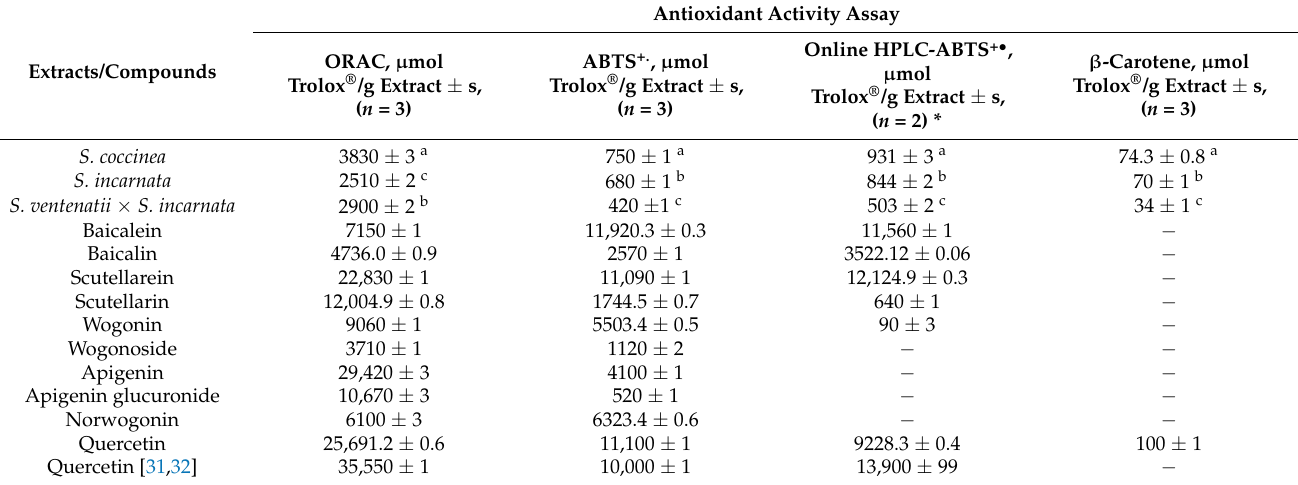
Table 5. In vitro antioxidant activity of standard compounds and of Scutellaria spp.